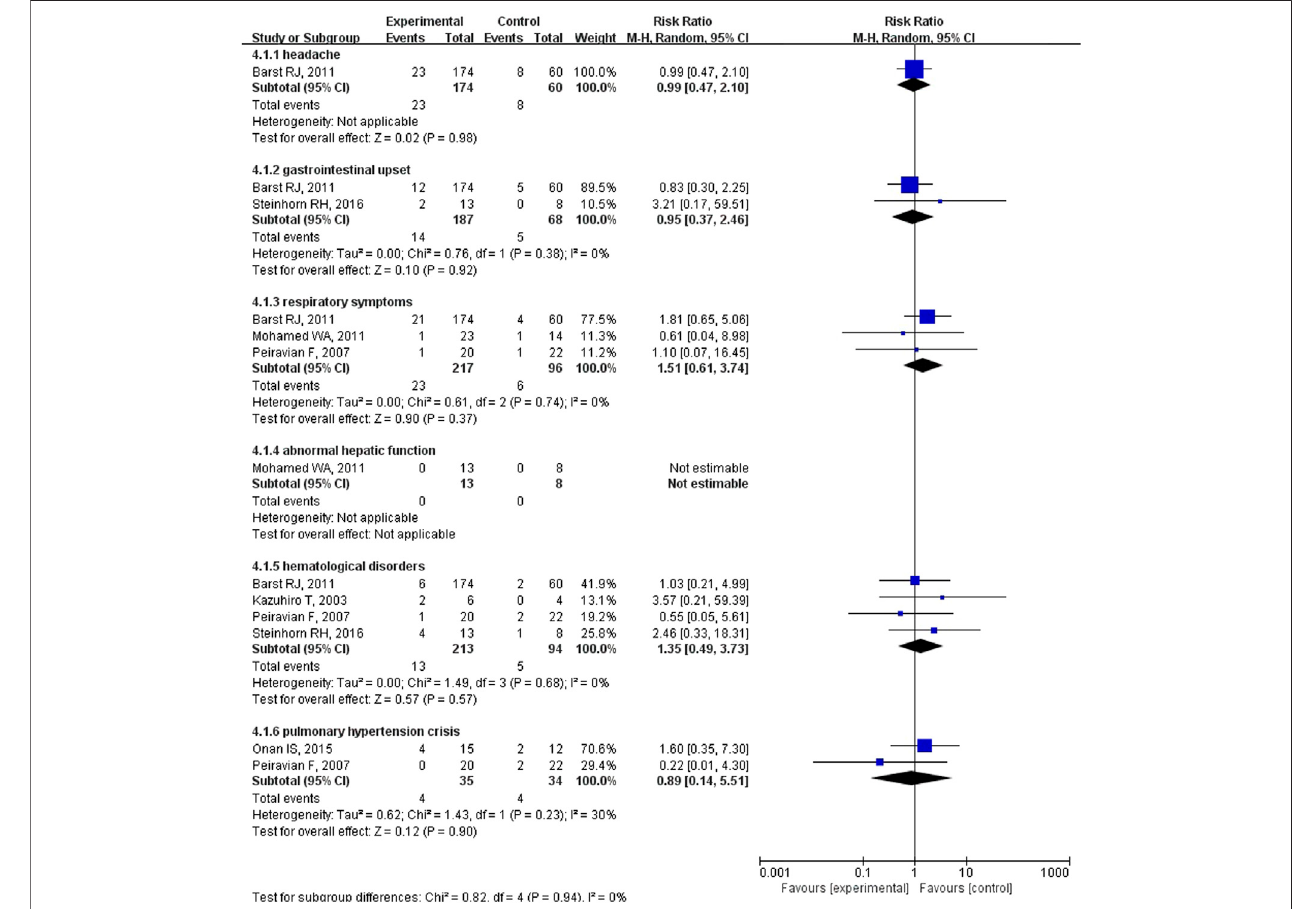
Frontiers in Pharmacology |